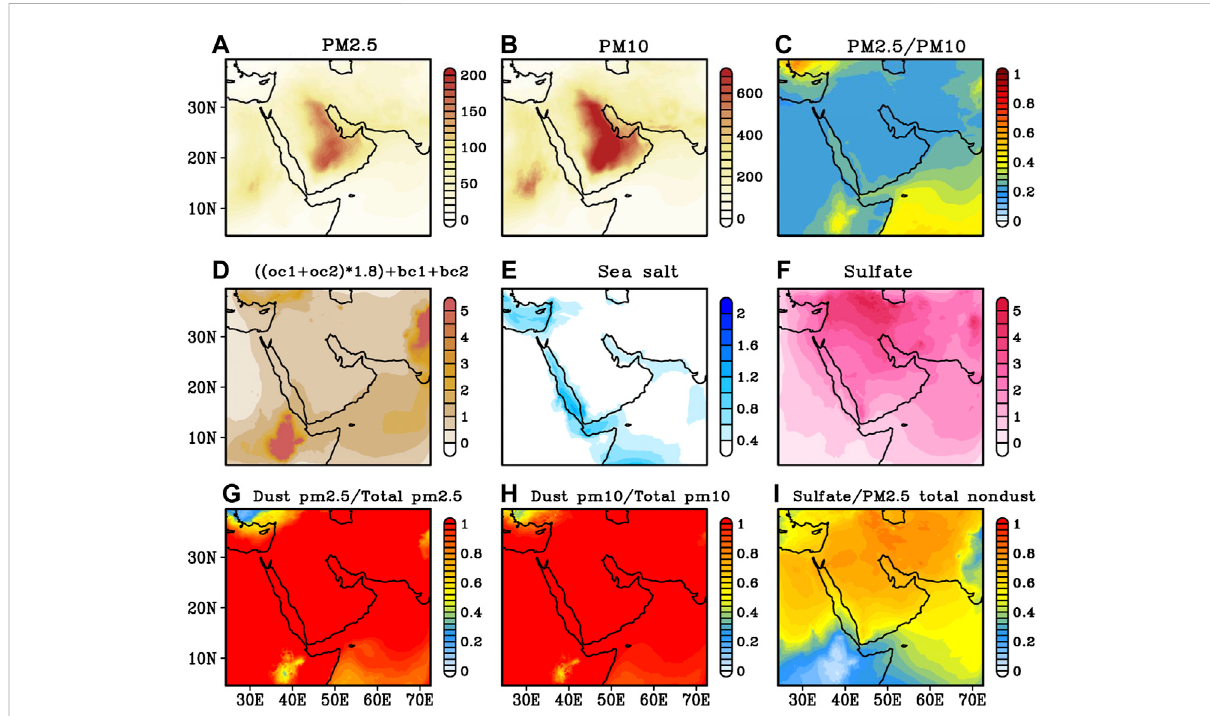
FIGURE 8 Spatial distributions of (A) PM 2.5 , (B) PM 10 , (C) ratio between PM 2.5 and PM 10 , (D) organic matter and black carbon ((OC hydrophobic + OC hydrophilic)xOCmassfraction(1.8)+BChydrophobic+BChydrophilic, (E) Seasalt, (F) Sulfate, (G) ratiobetweendustPM 2.5 andtotalPM 2.5 , (H) ratio between dust PM 10 and total PM 10 , and (I) ratio between sulfate and PM 2.5 total non-dust as simulated by WRF-Chem during the DLD period. All concentrations are in μ gm-3 except for